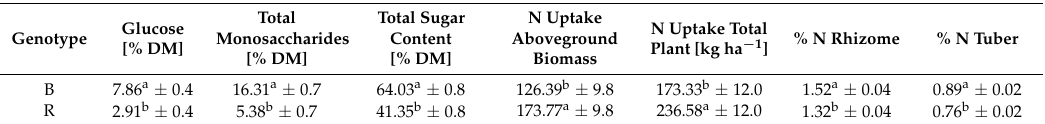
Table A1. Results of a multiple t-test at significance level of 5% after finding significant differences via global F-test for the factor genotype (brown and RG). Same lowercase letters indicate no significant differences between the genotypes.